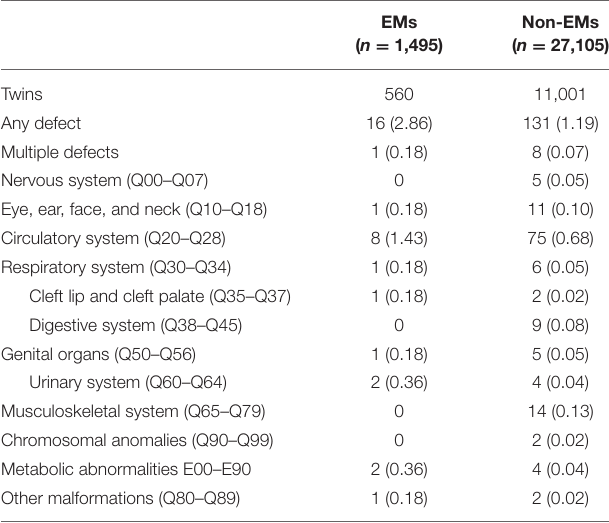
TABLE 4 | Proportion for birth defects of twin infants.